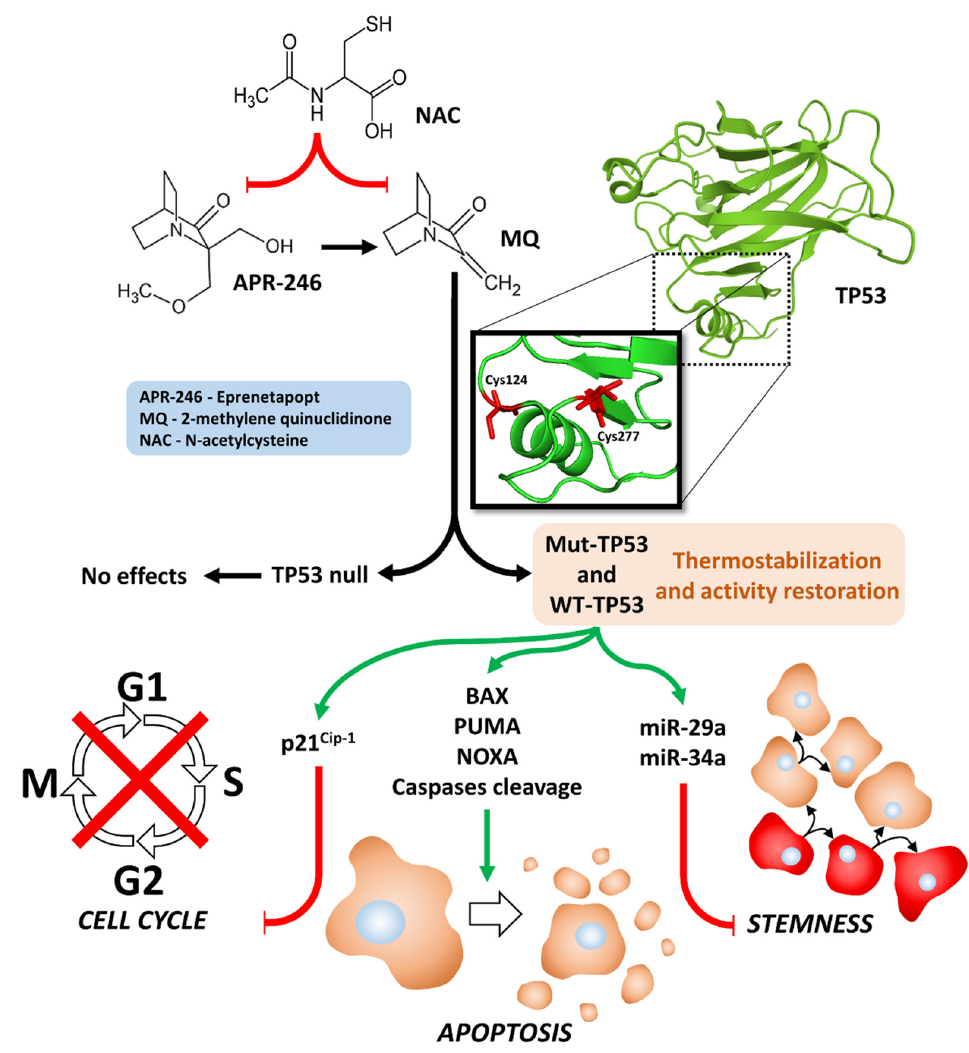
Figure 1. Illustration of effects of APR-246 on mutant and WT TP53 activities, inhibition of cell cycle progression, induction of apoptosis, induction of miRs, and inhibition of stemness.